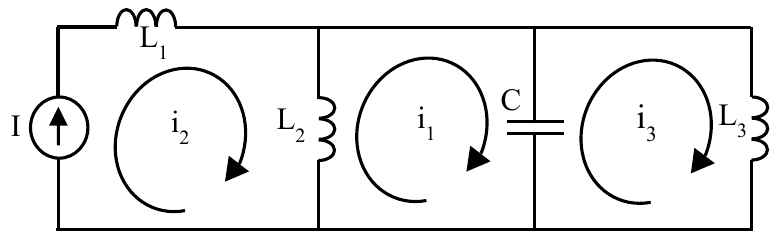
Figure 4. Filtered fault current and its Hilbert transform.